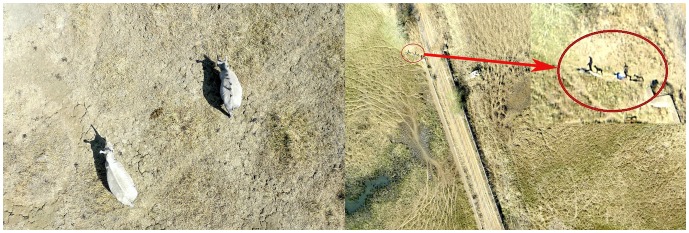
Images obtained with still photo camera.Left: Two rhinoceros (altitude 44 m AGL) in grassland habitat. Right: two people accompanied by two dogs near the fence (altitude 123 m AGL). These images were classified as “high quality”.